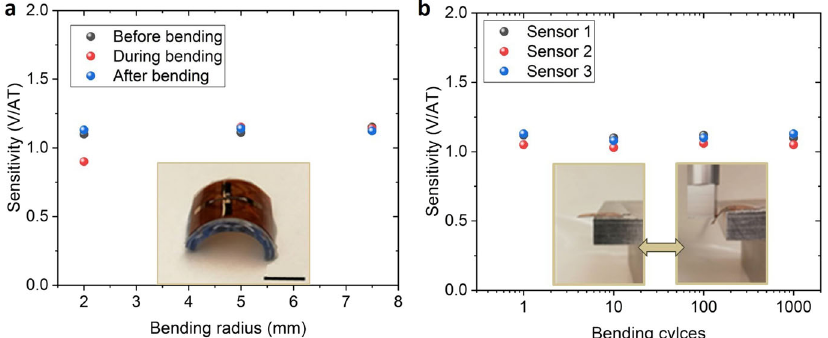
Fig. 3 Bending test of the fl exible LSG Hall sensor. a Current normalized sensitivity of the LSG Hall sensors before, during, and after one time bending to a certain radius. Scale bar of the inset image: 5 mm. b Bending cycle measurements of the current normalized sensitivity of the LSG Hall sensor.